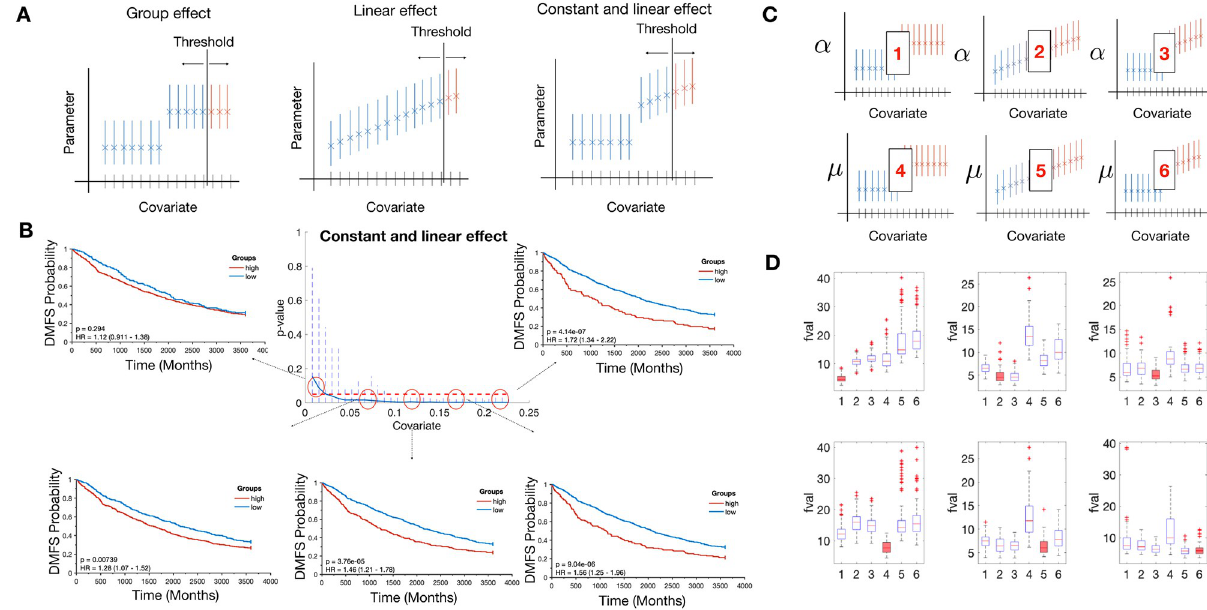
Fig 4. Effect of a continuous covariate. A) Individual values of α i or μ i are taken from different distributions depending on the covariate value and the type of effect. B) Synthetic DMFS curves at different thresholds simulated with a constant and linear effect in the variable α . P-values at different thresholds are displayed in the center figure C) Scheme of inferring the right effect from the data. Number 1–3 refers to effects group, linear, constant and linear in the variable α pop and 4–6 in the variable μ pop . D) Results from the minimization process with a gamma distribution for the covariate. Red box plots correspond to the real model used to generate the data with the model and Fval is the value of the objective function with the parameter estimated.